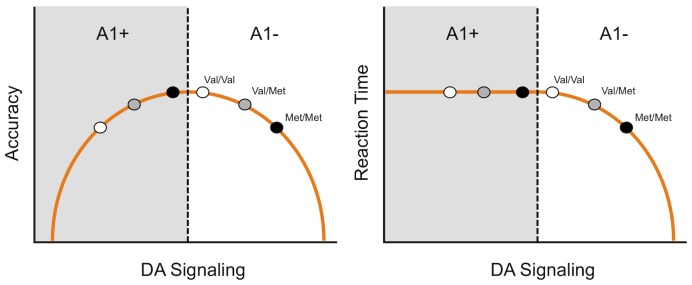
The hypothetical relationship between dopamine (DA) concentration and performance as measured by accuracy (left) or reaction time (right).The DRD2/ANKK1-TaqIa genotypes are indicated as A1+ (left panels) and A1− (right panels). COMT genotype is indicated as Val/Val (white), Val/Met (gray), or Met/Met (black).